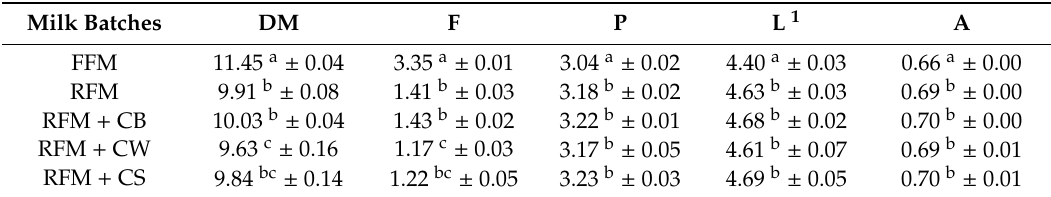
Table 2. Composition of the different milk batches used for cheese production (% w/v ). Milk Batches